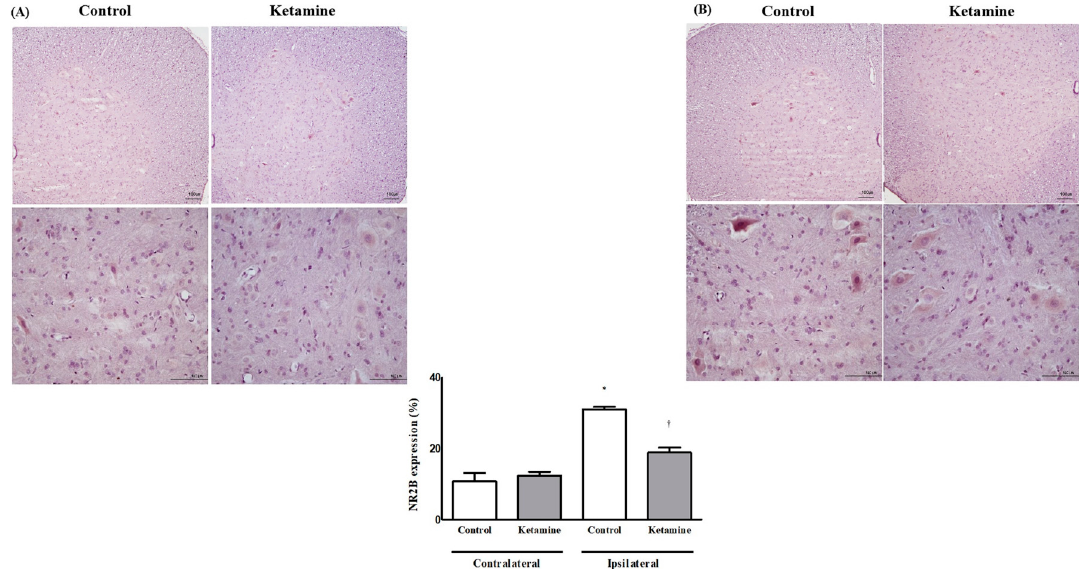
Figure 3. The expression of N-methyl-D-aspartate receptor subtype 2B (NR2B) in the spinal cord. ( A ) Contralateral side for the surgery with a magnified figure, × 40 (below) and ( B ) ipsilateral side for the surgery with a magnified figure, × 40 (below). Abbreviations: control, control group; ketamine, ketamine group. * p < 0.05 compared with the contralateral side in each group. † p < 0.05 compared with the control